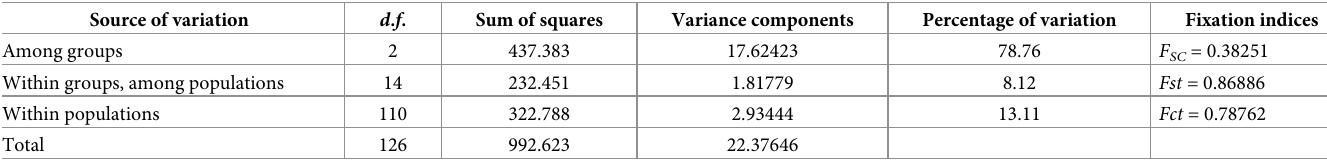
Table 5. Sources of variation calculated with SAMOVA under K = 3. Source of variation d . f . Sum of squares Variance components Percentage of variation Fixation